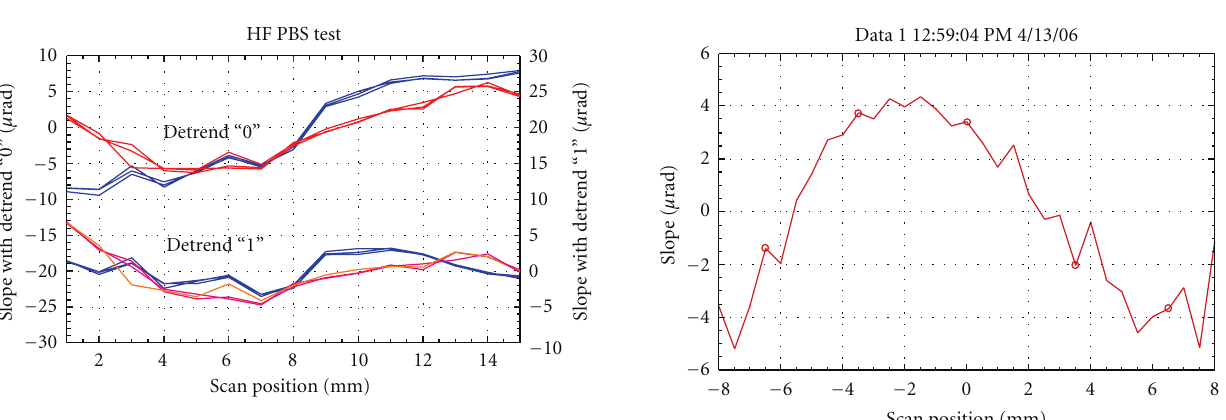
Figure 6: Results of slope measurement of the PBS produced in China, tested at 0 ◦ and 90 ◦ positions. At each position, it is scanned three 3 times.